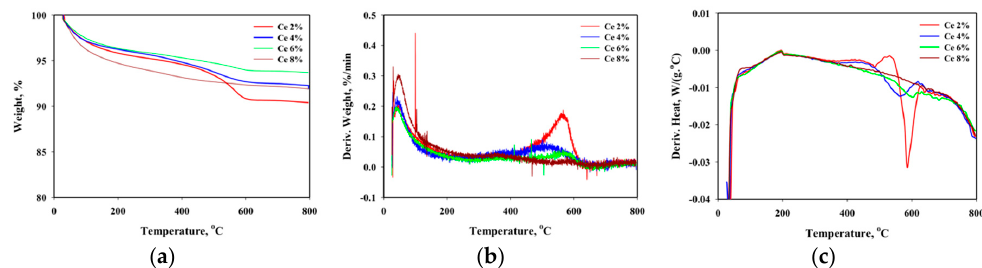
Figure 10. The results of TPO tests for pellet catalyst samples collected after auto-thermal reforming over Ni–Mg–Ce–Zr/Al 2 O 3 prepared with different CeO 2 contents at 800 °C, S/C = 2.0, and O 2 /C = 0.2; ( a ) TG thermogravimetric analysis curves, ( b ) derived weight, and ( c ) derived heat.